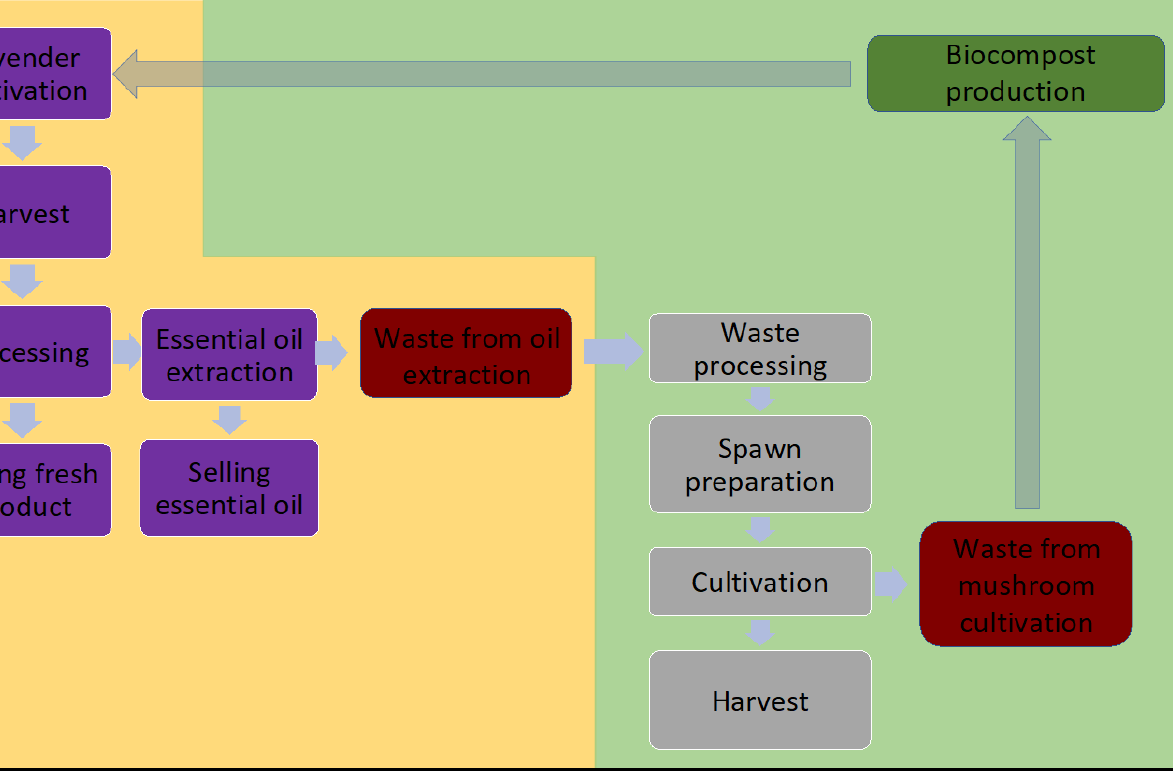
Figure 1. The entire circular process for mushroom cultivation. The yellow area concerns the cultivation of lavender and the essential oil production process. The green area represents the mushroom production process and the valorization of the spent substrates for biocompost production.